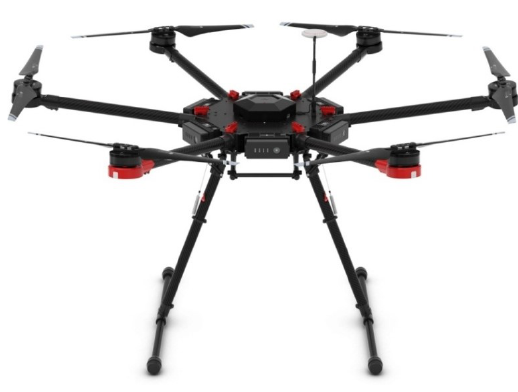
Figure 2. DJI Matrix 600 (Source: www.dji.com)